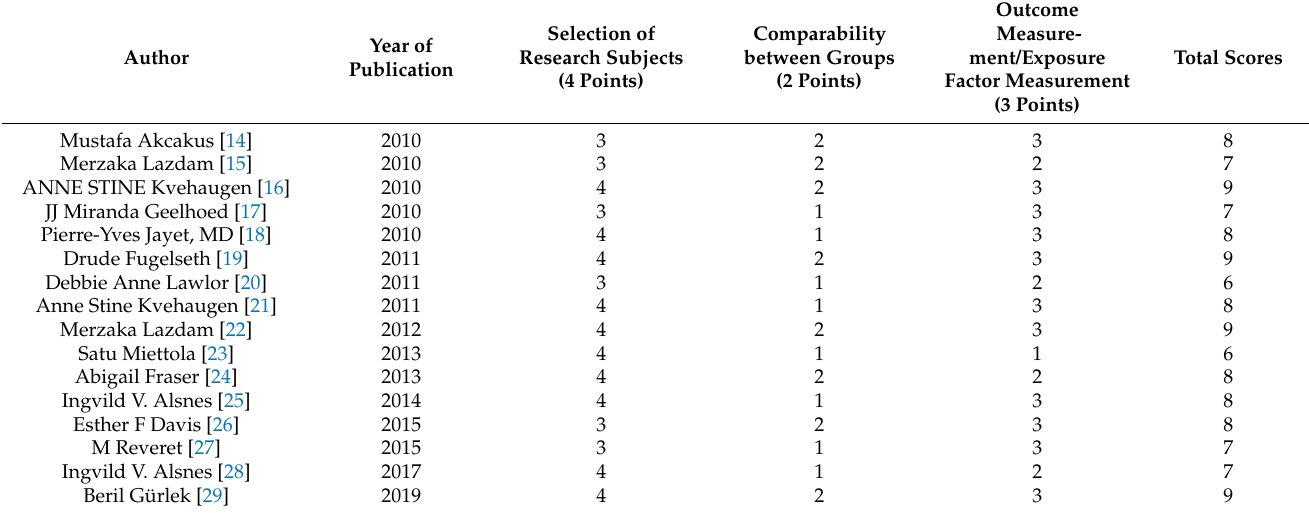
Table 1. Quality evaluation of included studies.